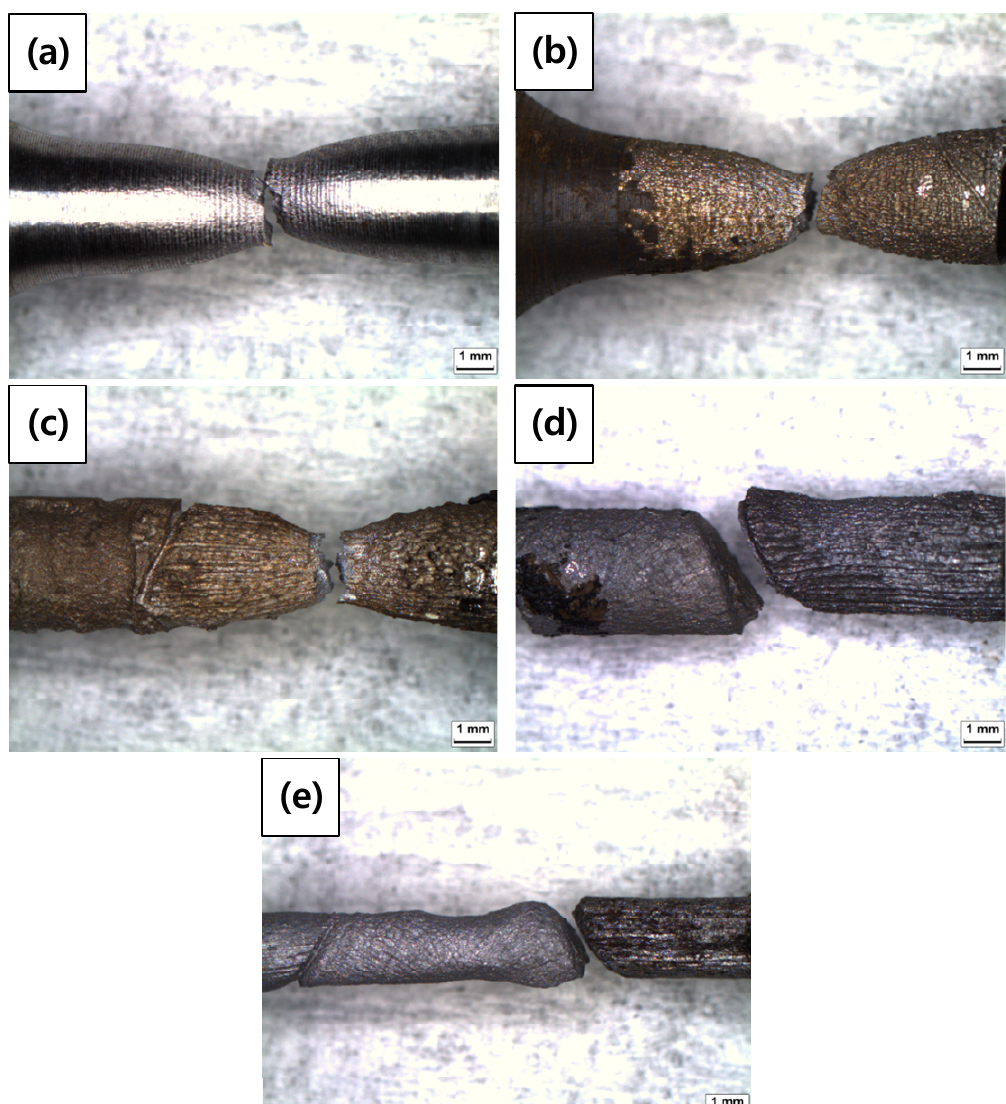
Figure 10. OM images of fracture morphologies of the corroded tensile specimens after tensile tests: ( a ) 0%, ( b ) 3%, ( c ) 10%, ( d ) 20%, and ( e ) 50% reduction ratios.